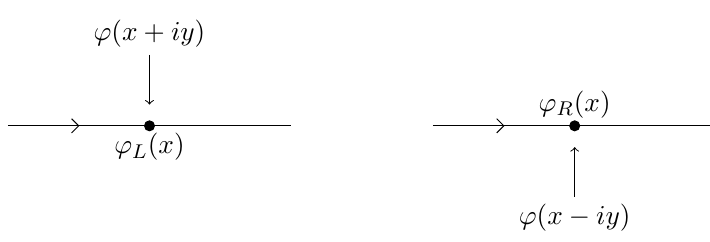
Figure 2 . The (cid:12)elds ’ L and ’ R de(cid:12)ned as limits of the bulk (cid:12)eld.